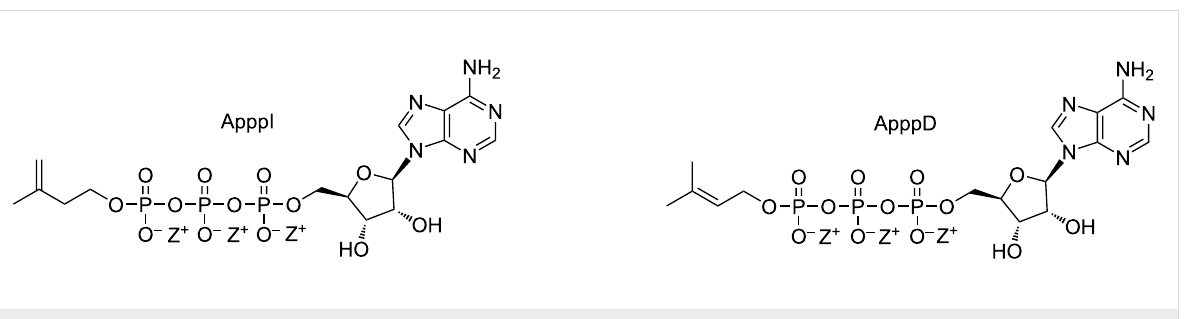
Figure 2: Structures of ATP analogues ApppI and ApppD (Z = Na or H).